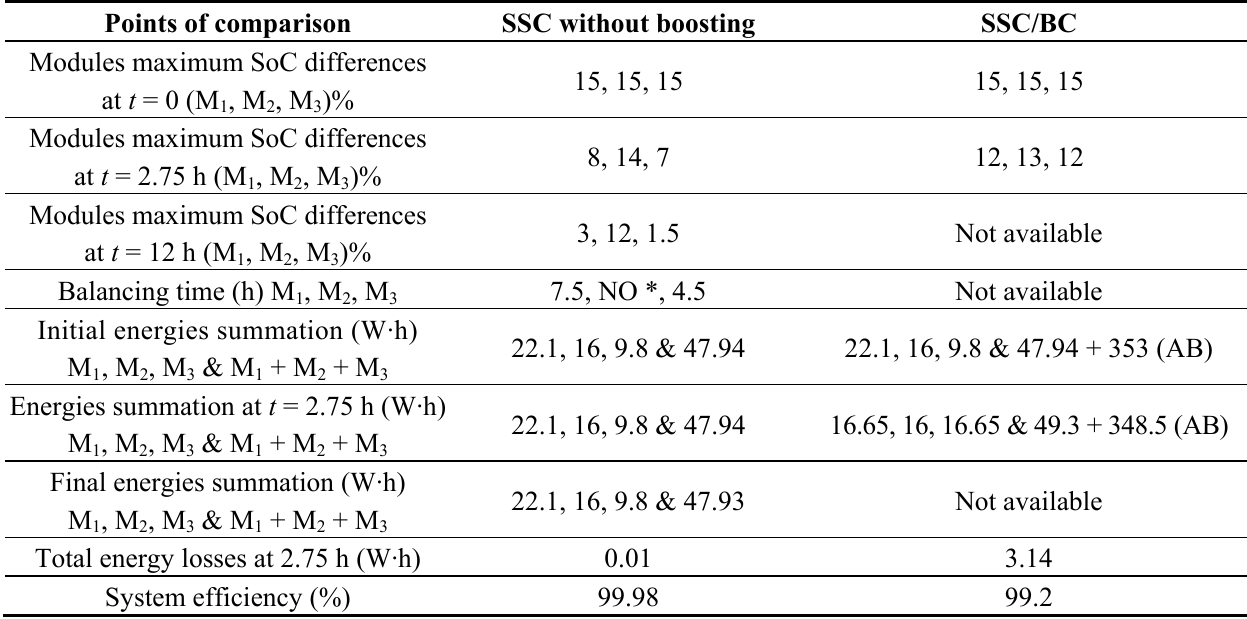
Table 1. SSC and SSC/BC battery balancing